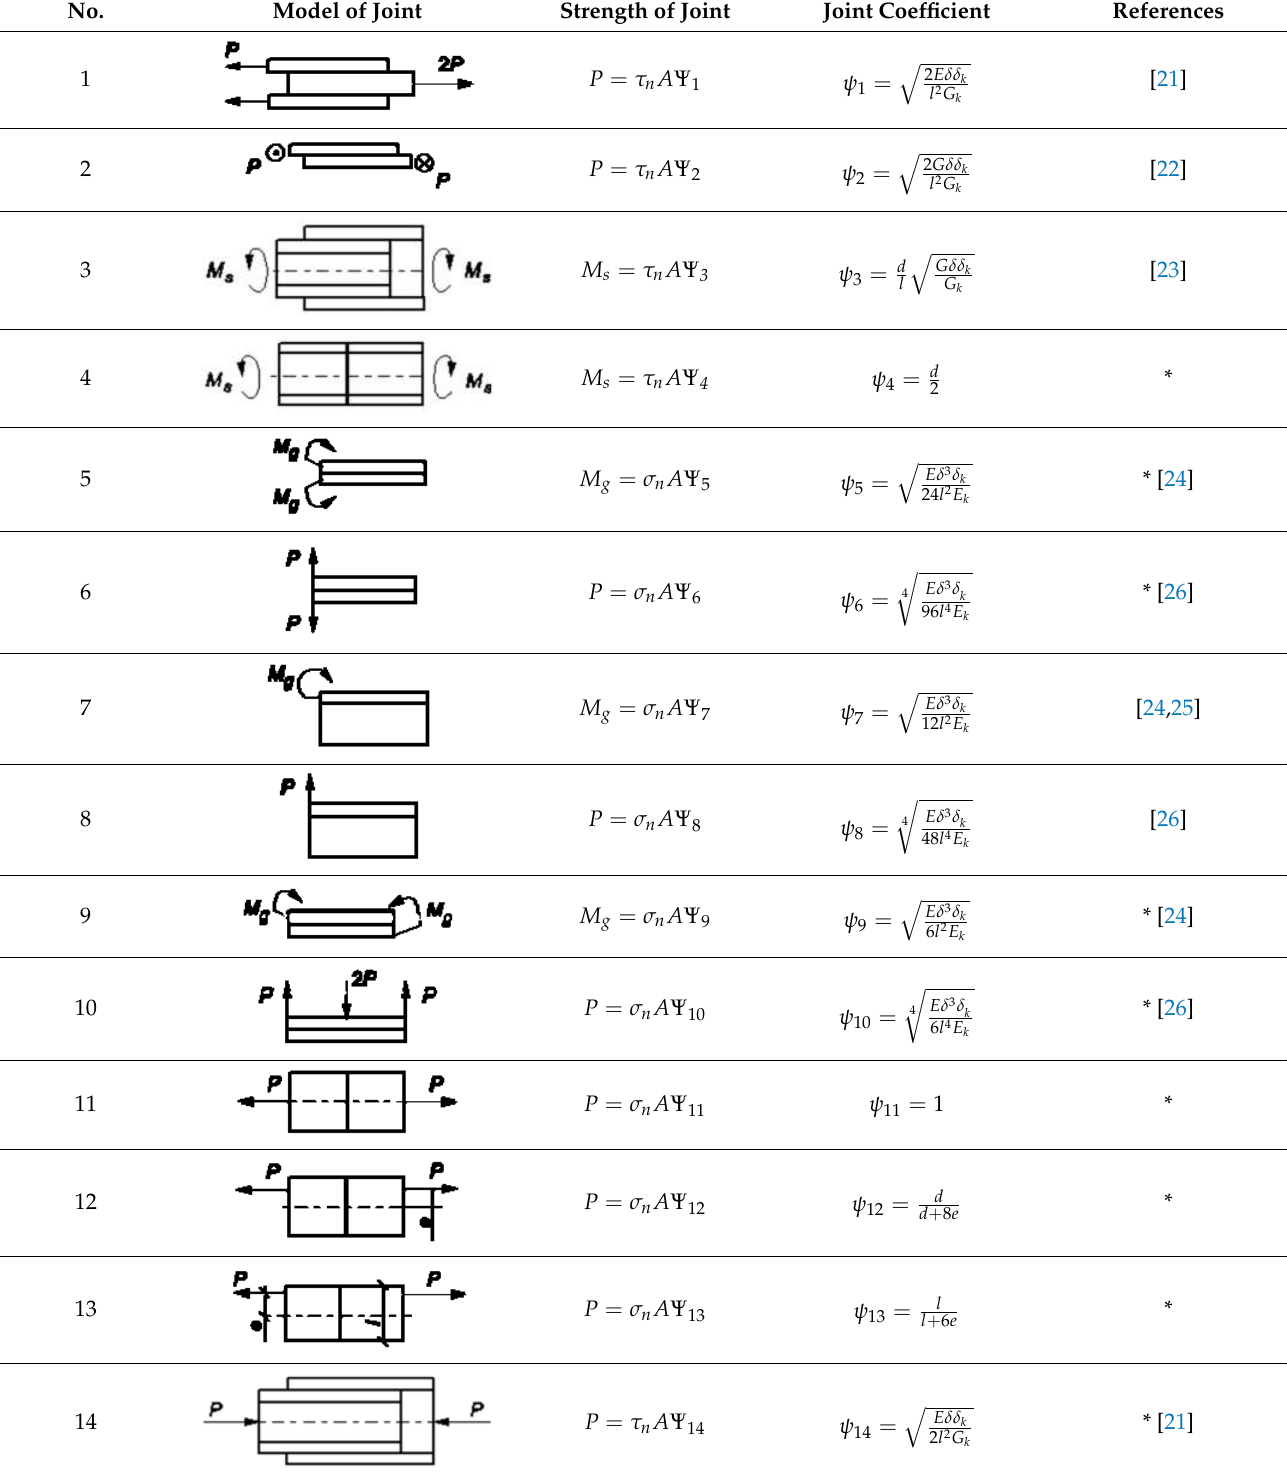
Table 1. Simplified formulas of adhesive joint coefficient for different joint loading valid for elastic adhesive (calculated on the basis of papers